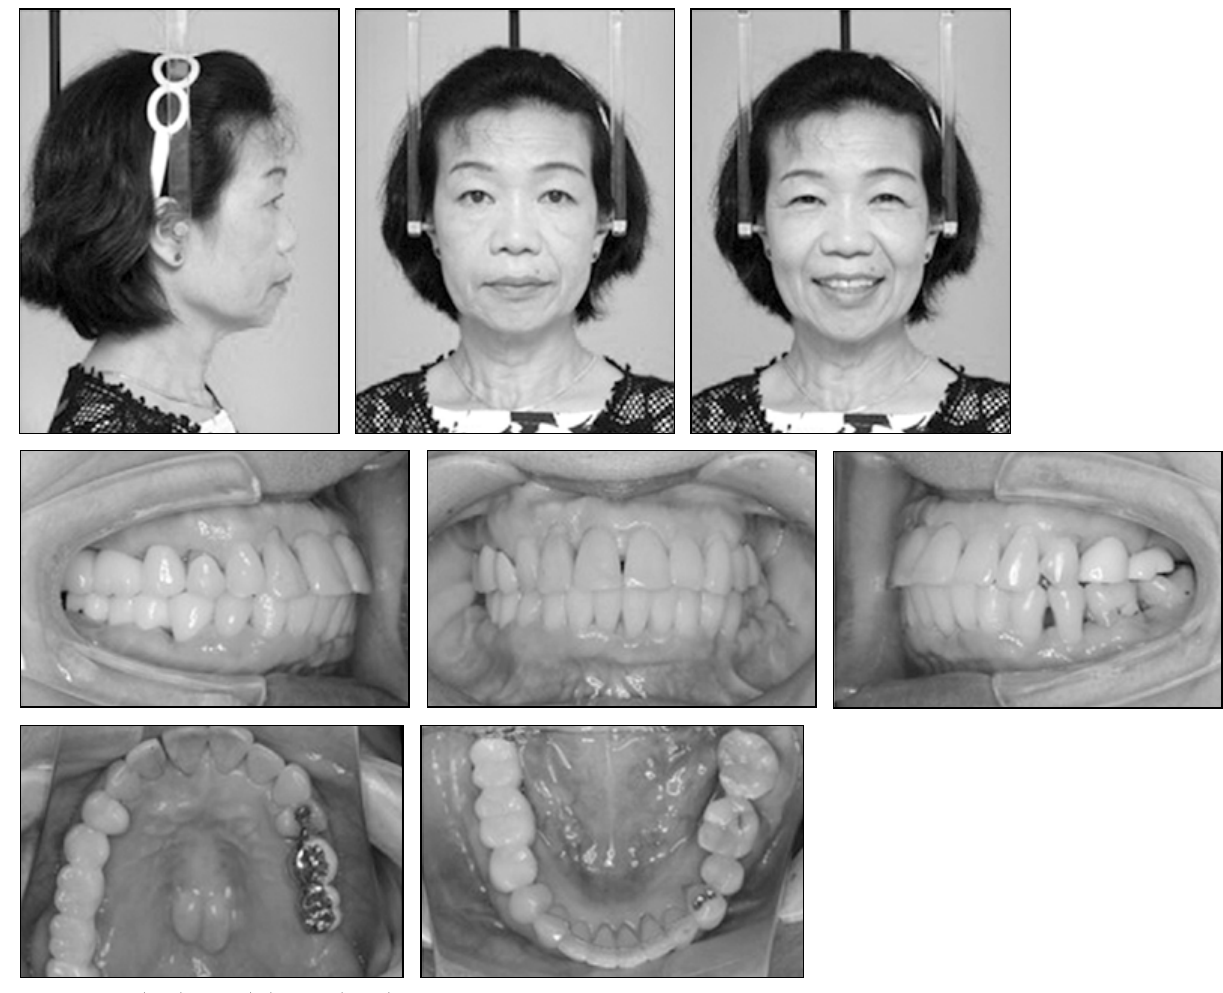
Figure 9. Facial and intraoral photographs at the two-year